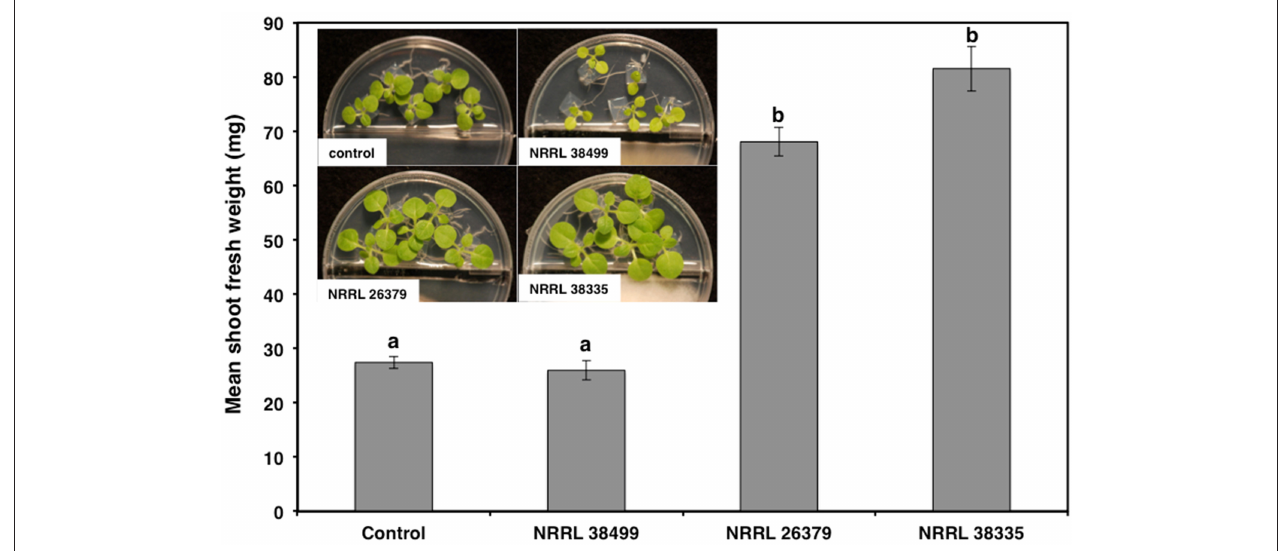
FIGURE 2 | Effect of F. oxysporum volatiles on N. tabacum growth. Shoot fresh weight was measured after 2 weeks of cocultivation with no fungus (control), NRRL 38499, NRRL 26379, and NRRL 38335. Representative plates are shown in the insert. Means and standard errors for nine biological replicates per treatment, with five seedlings per replicate, are shown. Different letters on columns represent statistically significant differences by one-way analysis of variance.